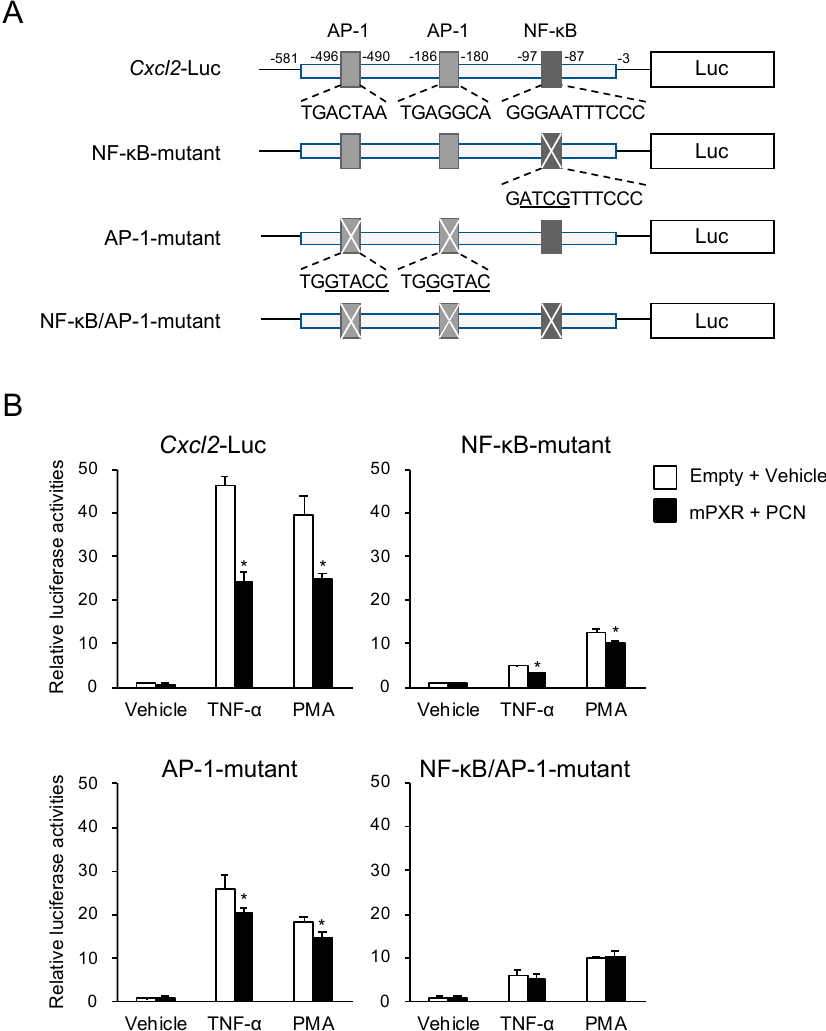
Figure 5. Effect of the mutation of NF- κ B and activator protein 1 (AP-1) binding sites on the PXR-dependent suppression of Cxcl2 expression. ( A ) Schematic representation of the reporter constructs is shown. Underlines indicate the mutated nucleotides. ( B ) 293T cells were transfected with each reporter plasmid shown in A, mPXR-pTargeT or control pTargeT, and control phRL-TK (total DNA: 100 ng/well). The cells were treated with 10 ng/mL TNF- α , 10 nM PMA, or vehicle (0.1% DMSO) in combination with or without 10 μ M PCN or vehicle (0.1% DMSO) for 24 h, and reporter activity was determined. Relative activity is shown compared to that in the cells transfected with empty pTargeT and treated with vehicle only (the left-end open bar) as 1. Values are presented as mean ± SD ( n = 4). * p < 0.05 (vs. “Empty + Vehicle”; Student’s t -test). Finally, to further confirm the suppressive effects of ligand-activated PXR on the transactivation by NF- κ B and AP-1, reporter assays were performed using a reporter construct containing consensus NF- κ B (5 ′ -GGGAATTTCC-3 ′ ) or AP-1 (5 ′ -TGACTAA-3 ′ ) binding motifs (Figure 6A). As GRIP1, a transcriptional coactivator, was recently reported to enhance gene transcription by NF- κ B or AP-1 [17], we expressed GRIP1 in this system (Figure 6A, right). With the reporter plasmid containing NF- κ B binding motifs, the luciferase activity was increased via TNF- α treatment by approximately 18- and 35-fold in the absence and presence of GRIP1, respectively, and the increase was substantially